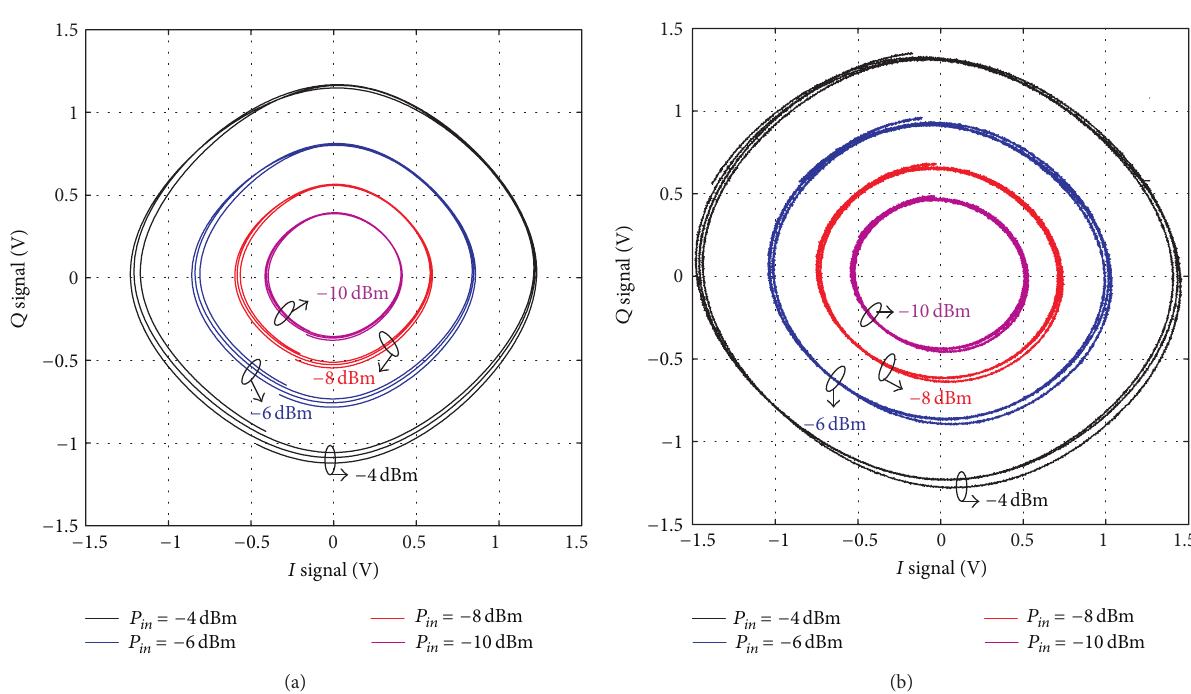
Figure 10: 𝐼/𝑄 diagram for carrier frequency = [5, 5.2]GHz and P 𝑖𝑛 = [ − 10, − 4] dBm; (a) simulations and (b)